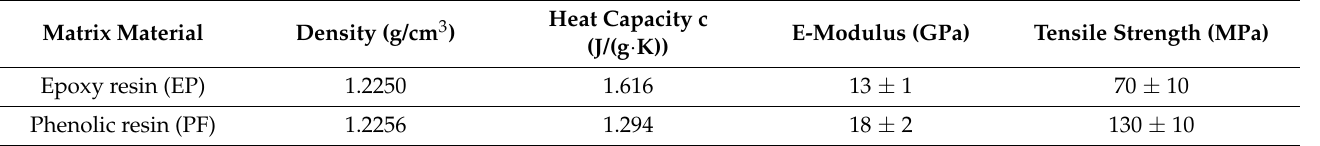
Table 1. Specification of matrix material including density and heat capacity c (own measurements) as well as E-modulus and tensile strength (manufacturer’s specifications).